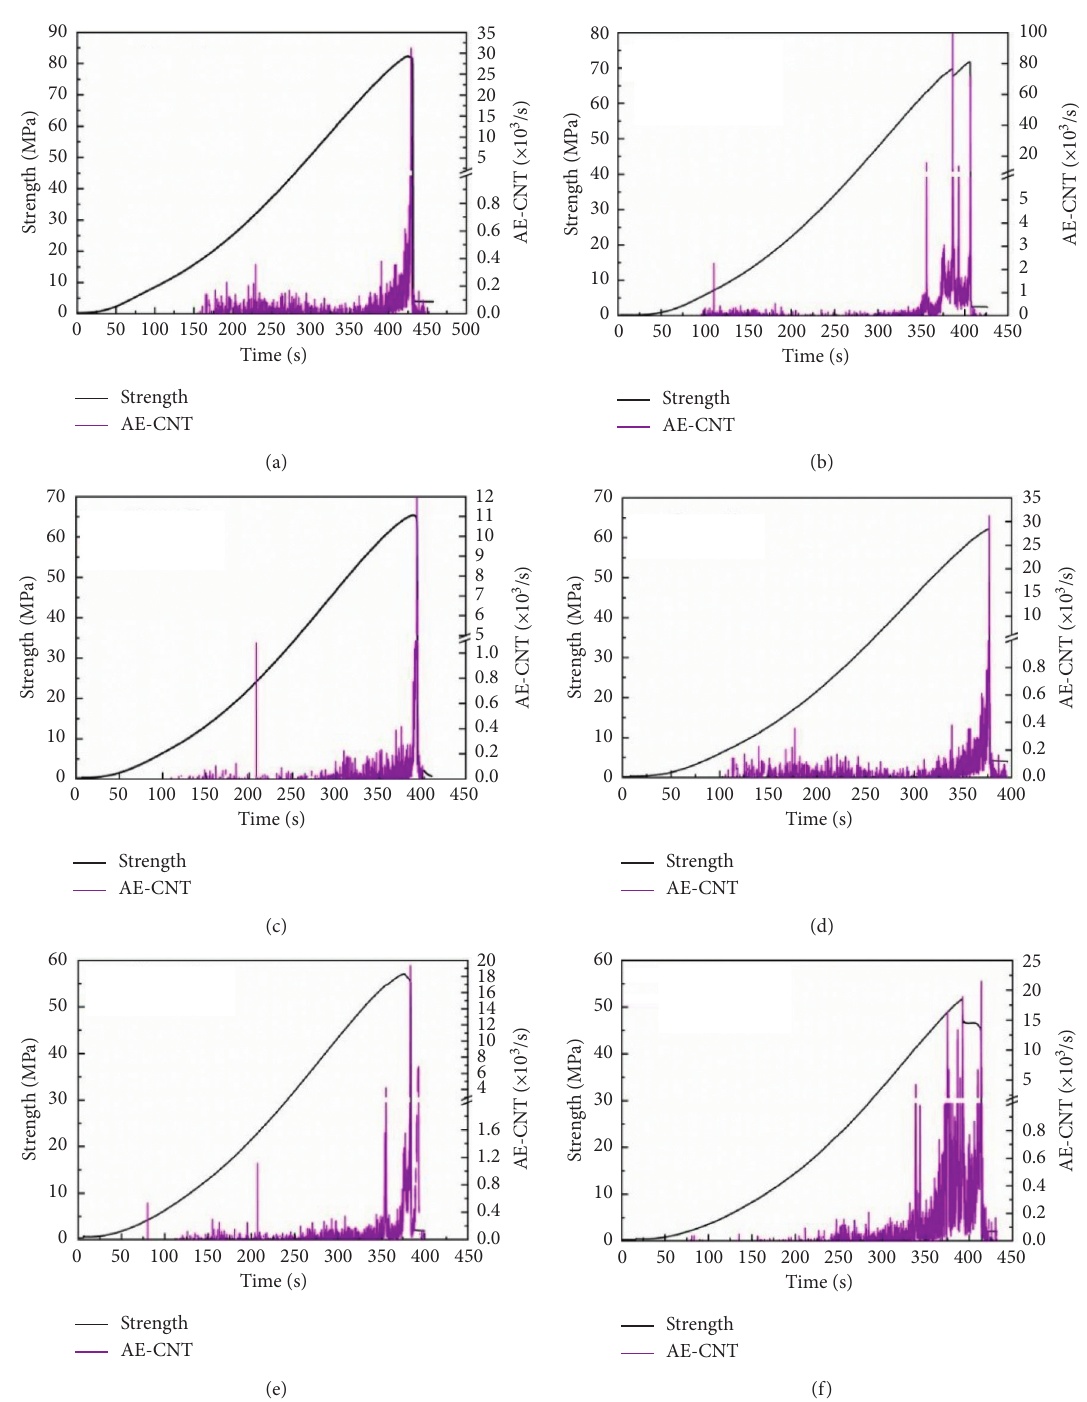
Figure 11: Relation of ringing count-stress with time. (a) ω � 0%. (b) ω � 0.57%. (c) ω � 1.06%. (d) ω � 1.82%. (e) ω � 2.43%. (f) ω �